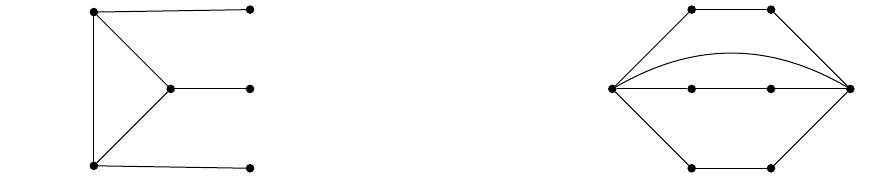
Figure 1. For the graph G for the graph G